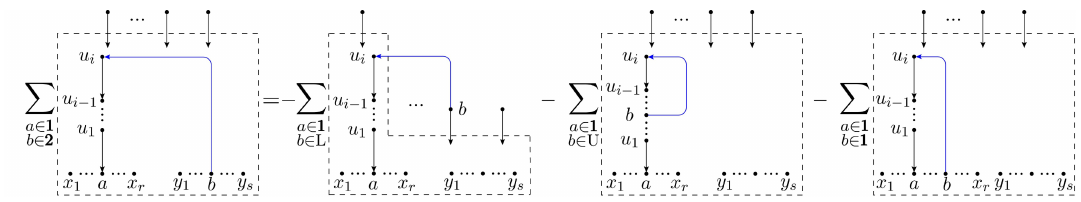
Figure 6 . Transformation-3 of spanning forests with the type-1 edge e ( b, u i ) .